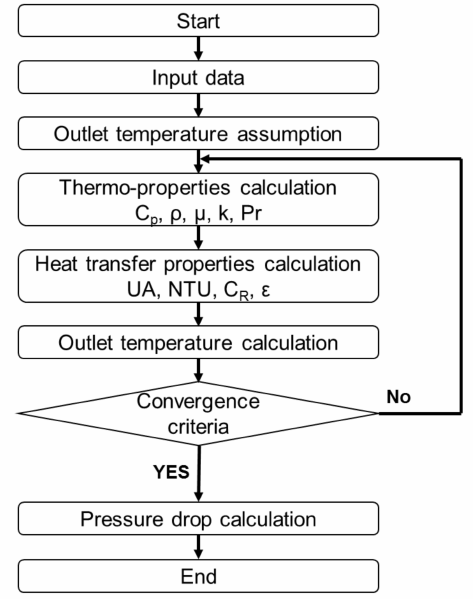
Figure 3. Heat exchanger performance analysis flow